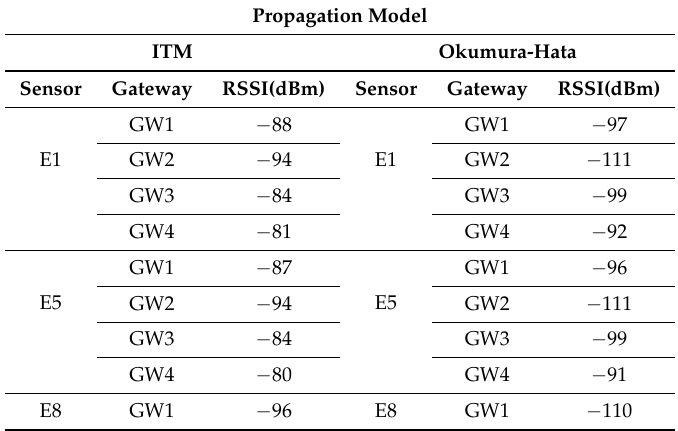
Table 6. RSSI values calculated with CloudRF Best Server